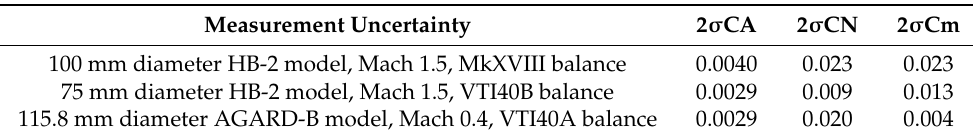
Table 1. Example of measurement uncertainty of aerodynamic coefficients, HB-2 and